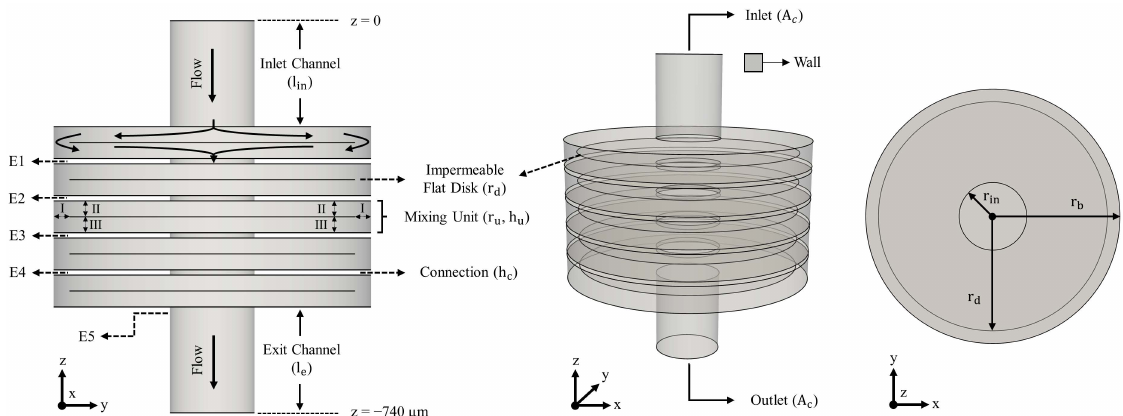
Figure 1. Different views of the 3-D CSFO micromixer geometry. E1, E2, E3, E4, and E5 are the locations 5 µ m after the exit of each mixing box.